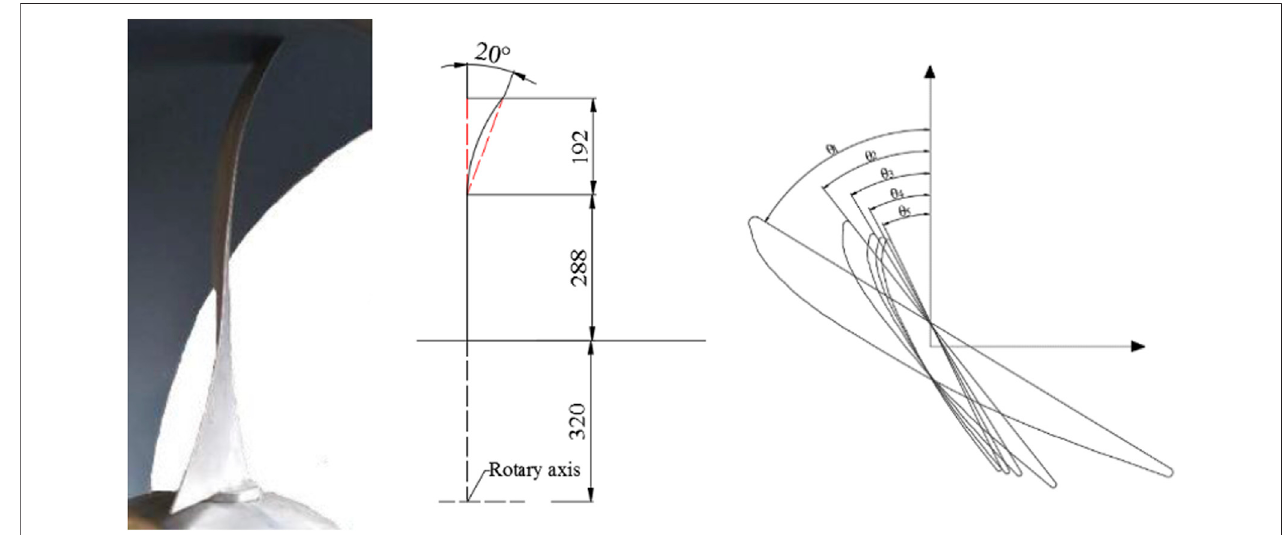
FIGURE 2 | Parameters of the forward-swept blade.